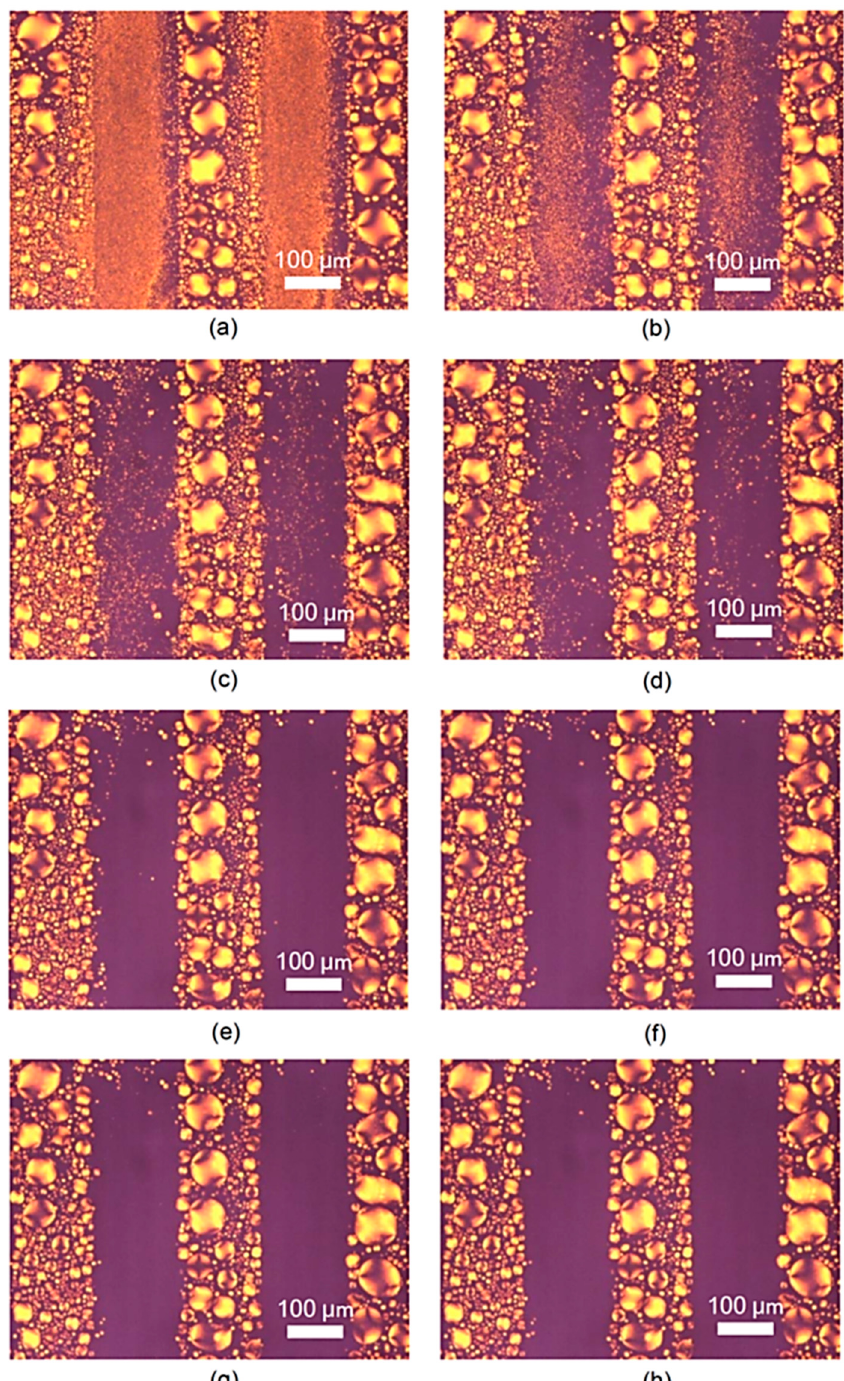
Figure 3. Image of the grating sample with binary PVK layer recorded at the constant- T R step under the POM with crossed polarizers at observation time t R = ( a ) 0 h, ( b ) 1 h, ( c ) 2 h, ( d ) 4 h, ( e ) 7 h, ( f ) 10 h, ( g ) 13 h, and ( h ) 16 h.